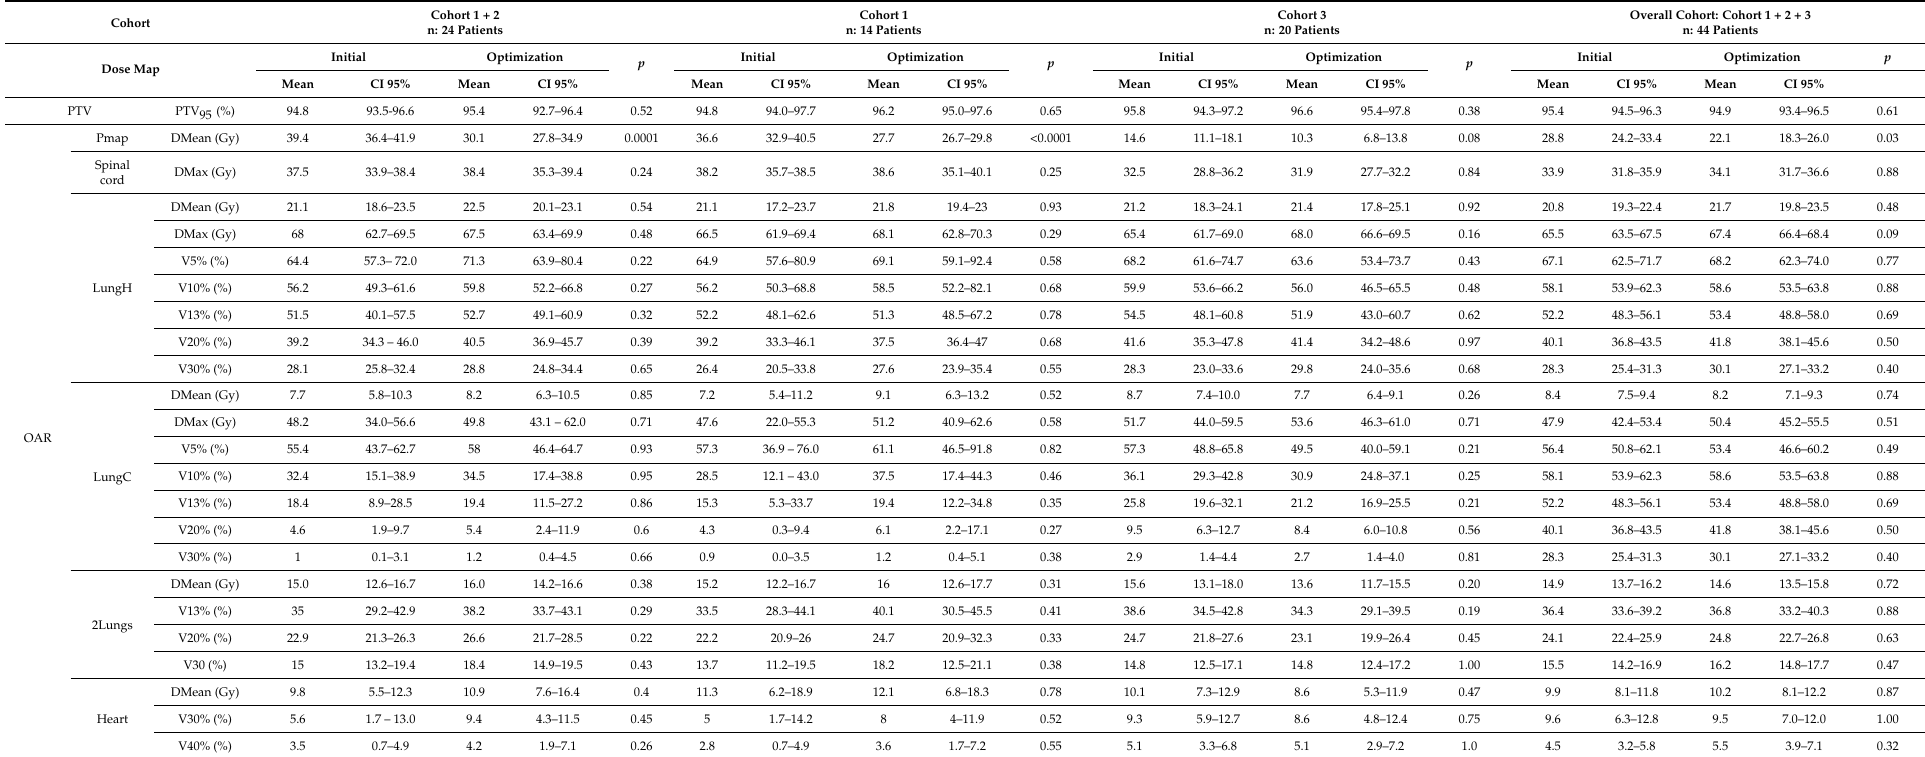
Table 1. Dose–volume histograms’ parameters between the initial and optimized plannings in each